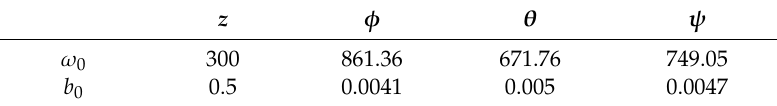
Table 3. LESOs Parameters of the leader